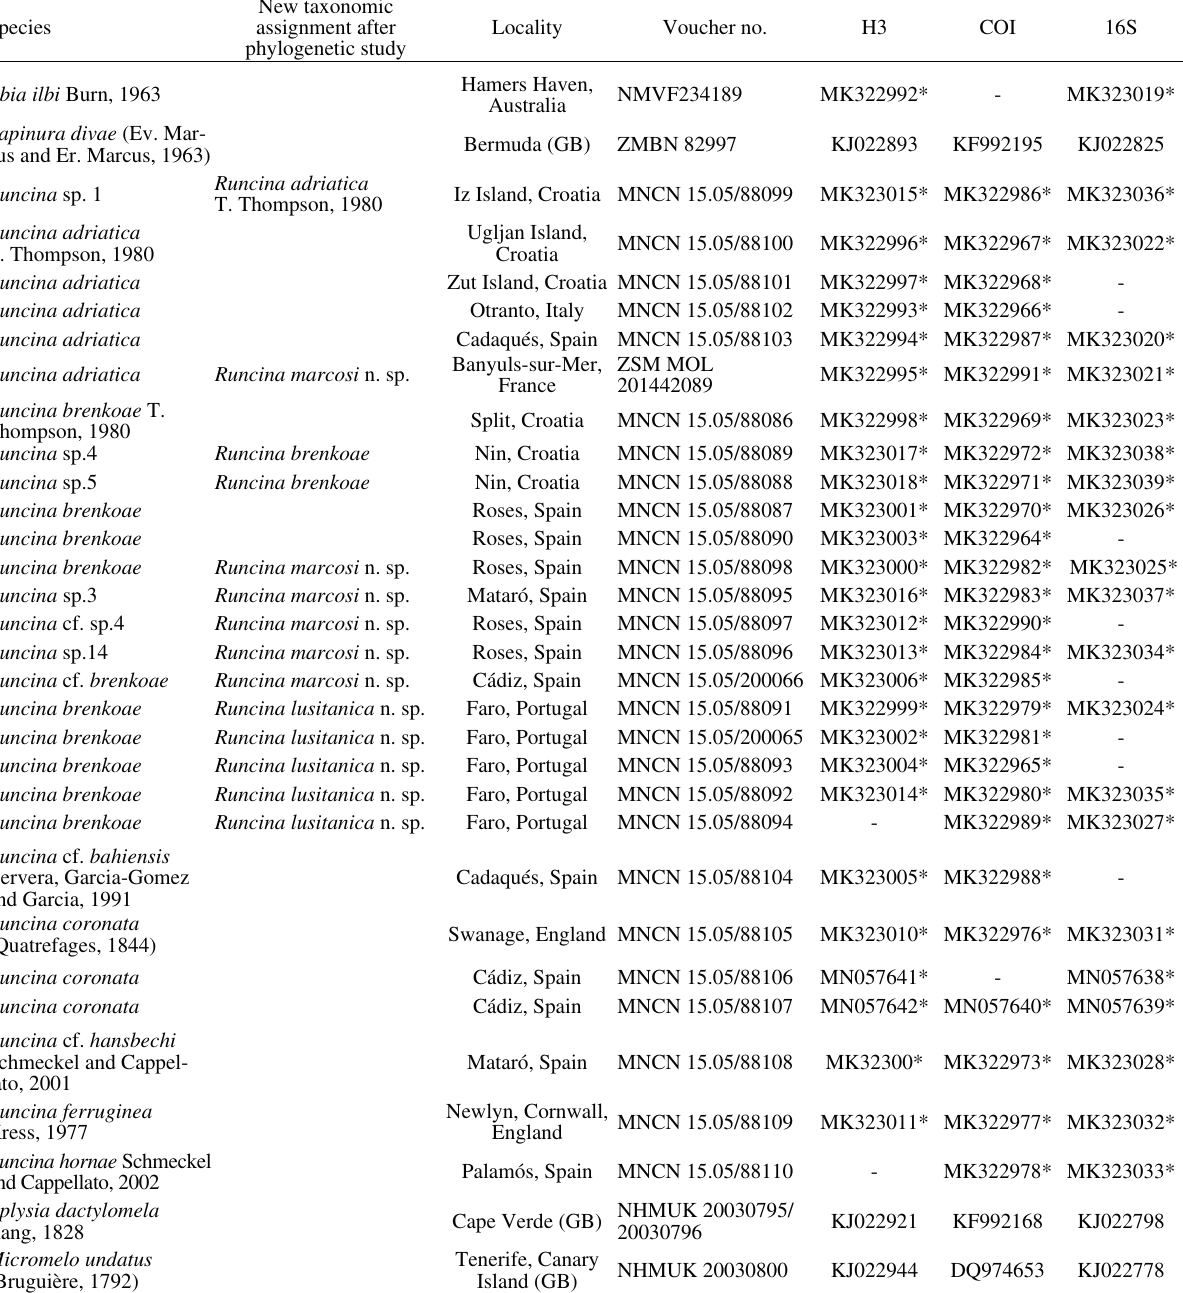
Table 1. – List of specimens used for phylogenetic analysis. (*) New sequences generated for this study. GB: GenBank. Museum abbre- viations: Museum Victoria collections (NMVF), University Museum of Bergen (ZMBN) Zoologische Staatssammlung München, Germany (ZSM), Museo Nacional de Ciencias Naturales (MNCN) and The Natural History Museum, London, United Kingdom